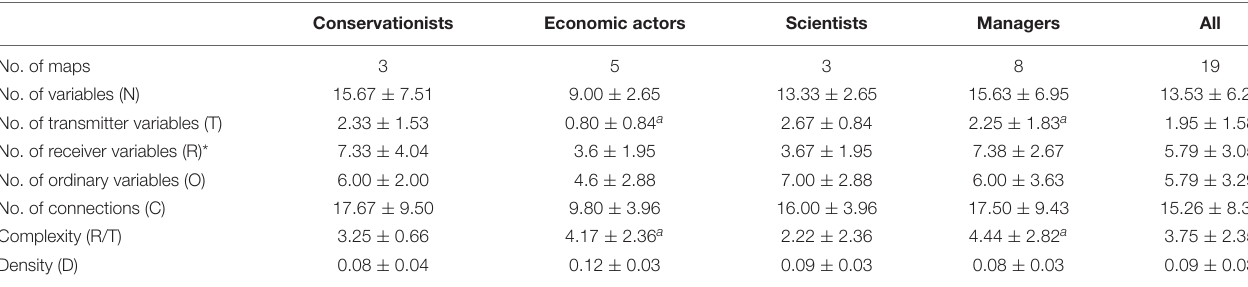
TABLE 2 | Graph theory indices of the individual FCMs: mean and standard deviation by stakeholders